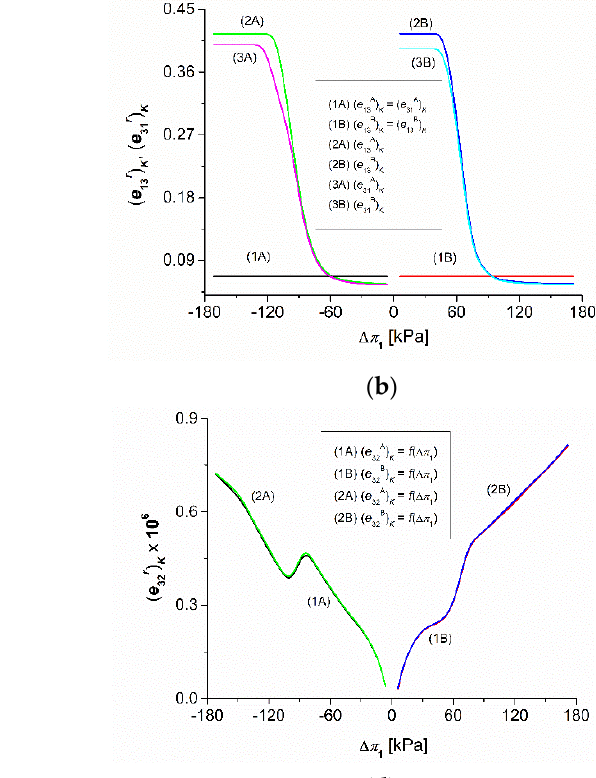
) ) ) ) ) ) and ( e r ( a ), ( e r and ( e r ( b ), ( e r ( c ), ( e r ( d 23 32 12 21 13 31 K r K r K r K r K r K r